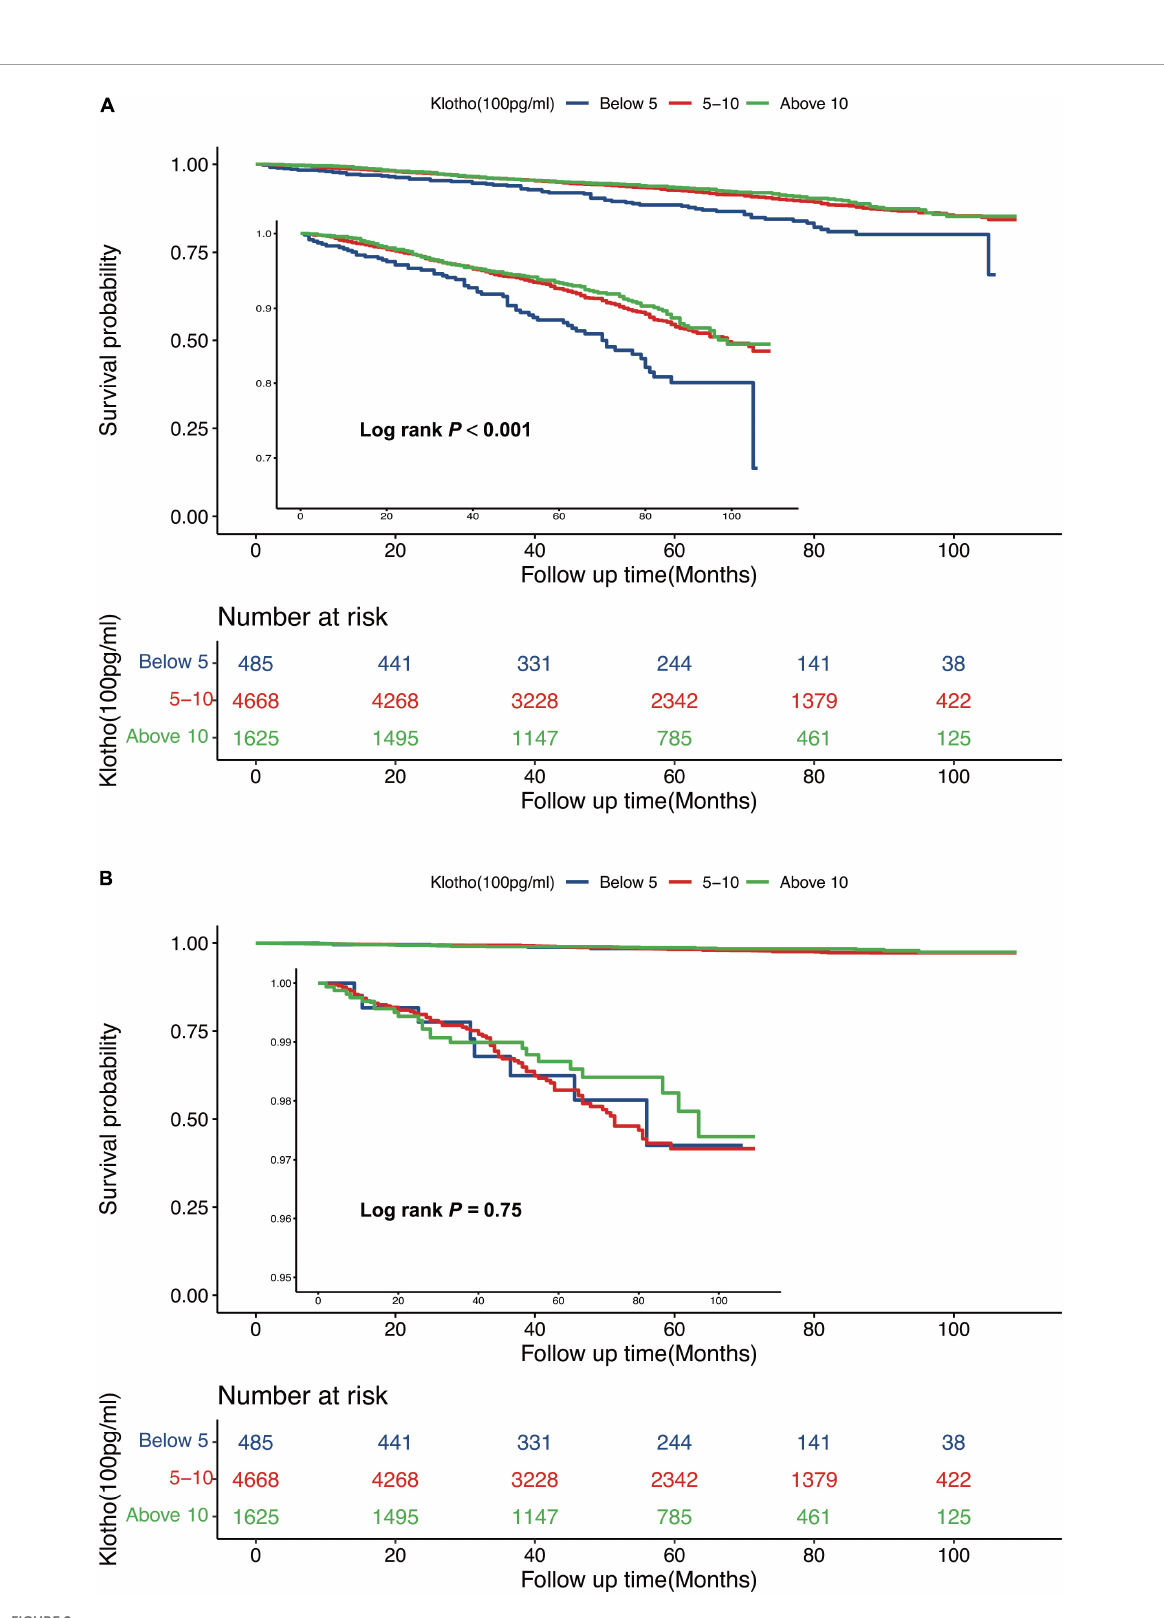
FIGURE2 Kaplan-Meier (crude) survival curves, by serum Klotho concentrations, for all-cause mortality (A) and cardiovascular mortality (B)